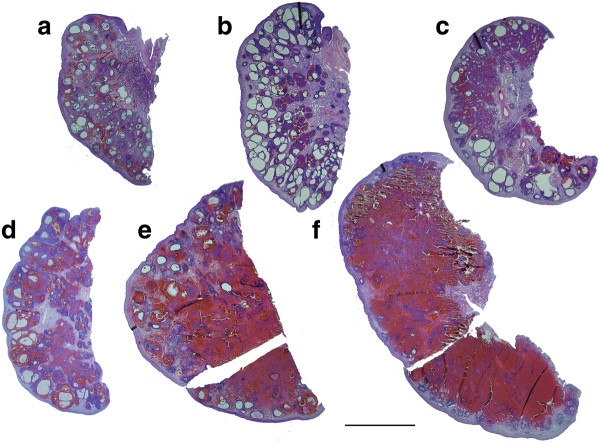
 Photographs taken above a light box of 25 μm thick sections of fetal elephant ovaries recovered between 15 and 21 months of gestation (Scale bar = 10 mm).a) 15.2 months; the cortical region surrounds a central medulla filled with small growing and antral follicles and dark staining interstitial tissue. b) 16.7 months; showing maximum recorded antral follicle development. c) 17.1 months; the number of antral follicles is less than in (b) and more interstitial tissue is apparent. d) 17.5 months; increasing vascularisation of the ovary is apparent. e) 19.3 months; ovarian size has increased significantly from (d) due to hypertrophy and hyperplasia of interstitial cells. f) 20.2 months; the fetal ovary is approaching maximum size. Few antral follicles remain and, as in e), the interstitial tissue is partially obscured by extravasated red blood cells.